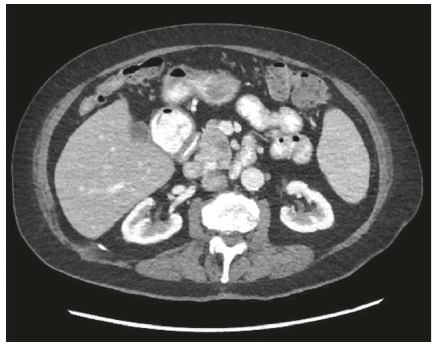
Figure 3: CT abdo/pelvis: normal-appearing